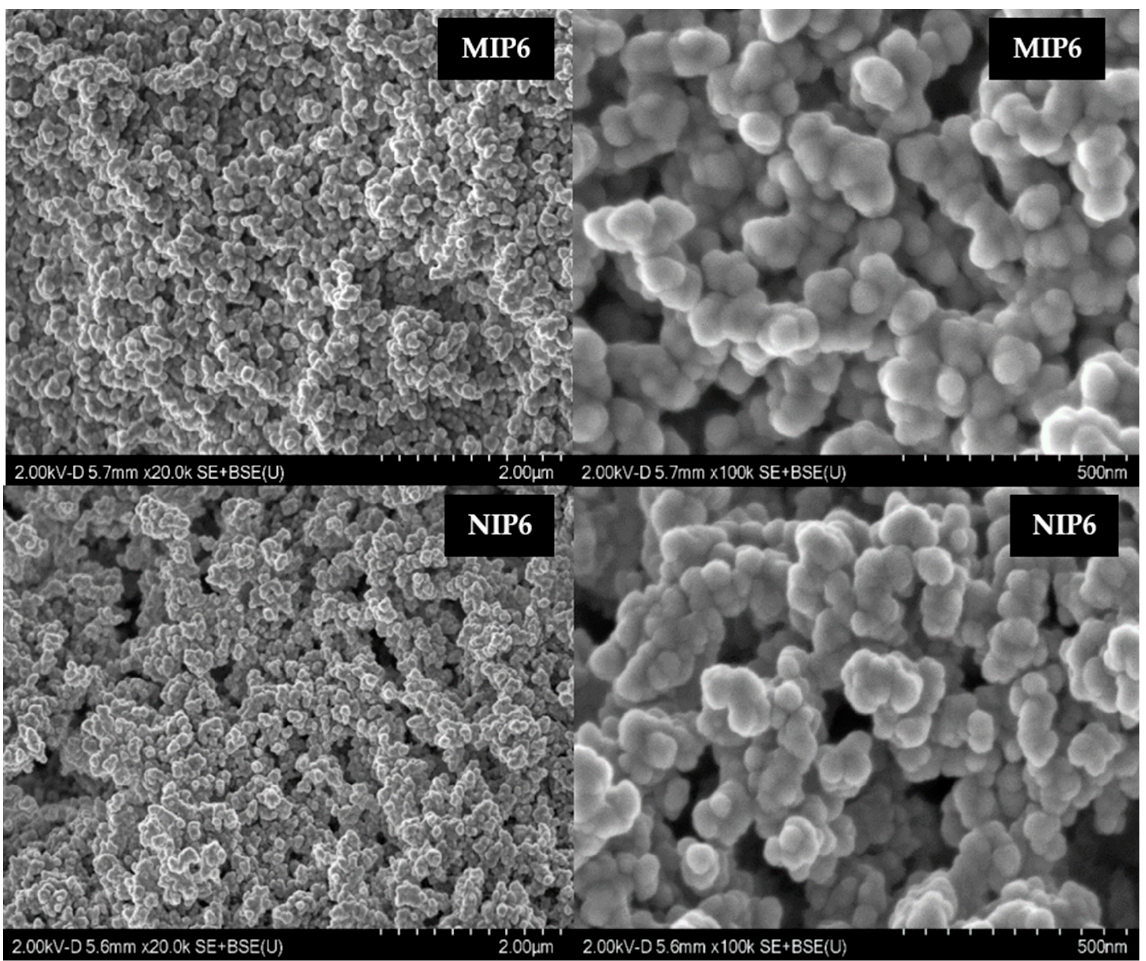
Figure 3. SEM images for MIP6 and NIP6 at di ff erent